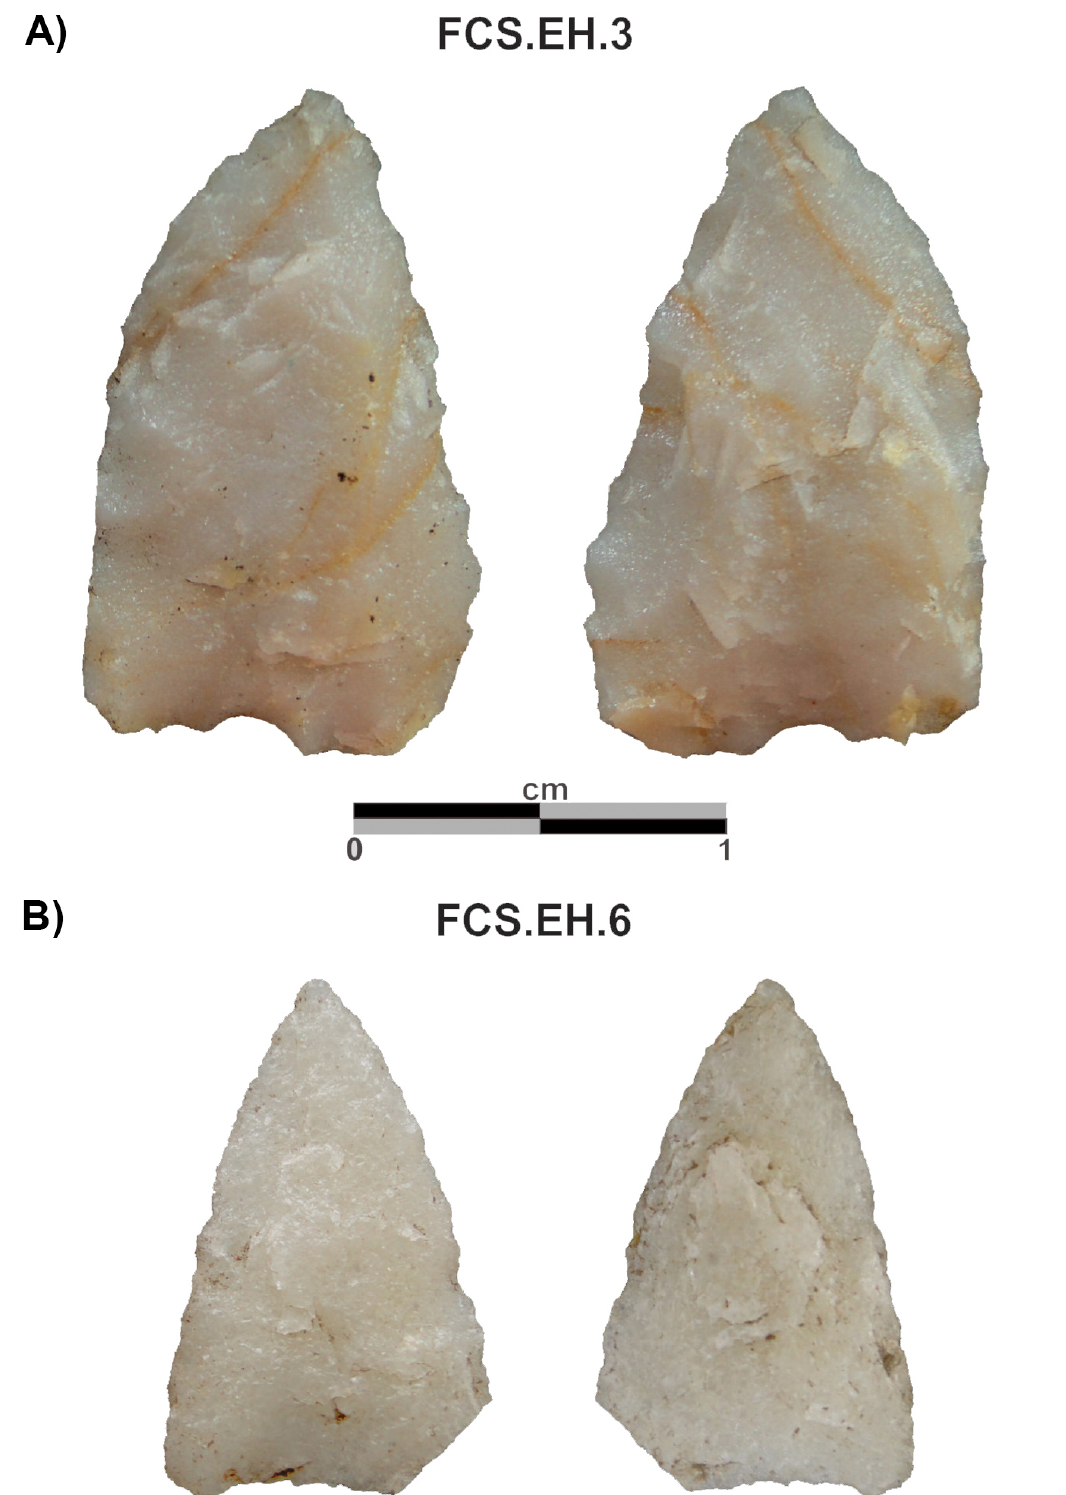
Figure 3. Preform and arrow manufactured on orthoquartzite